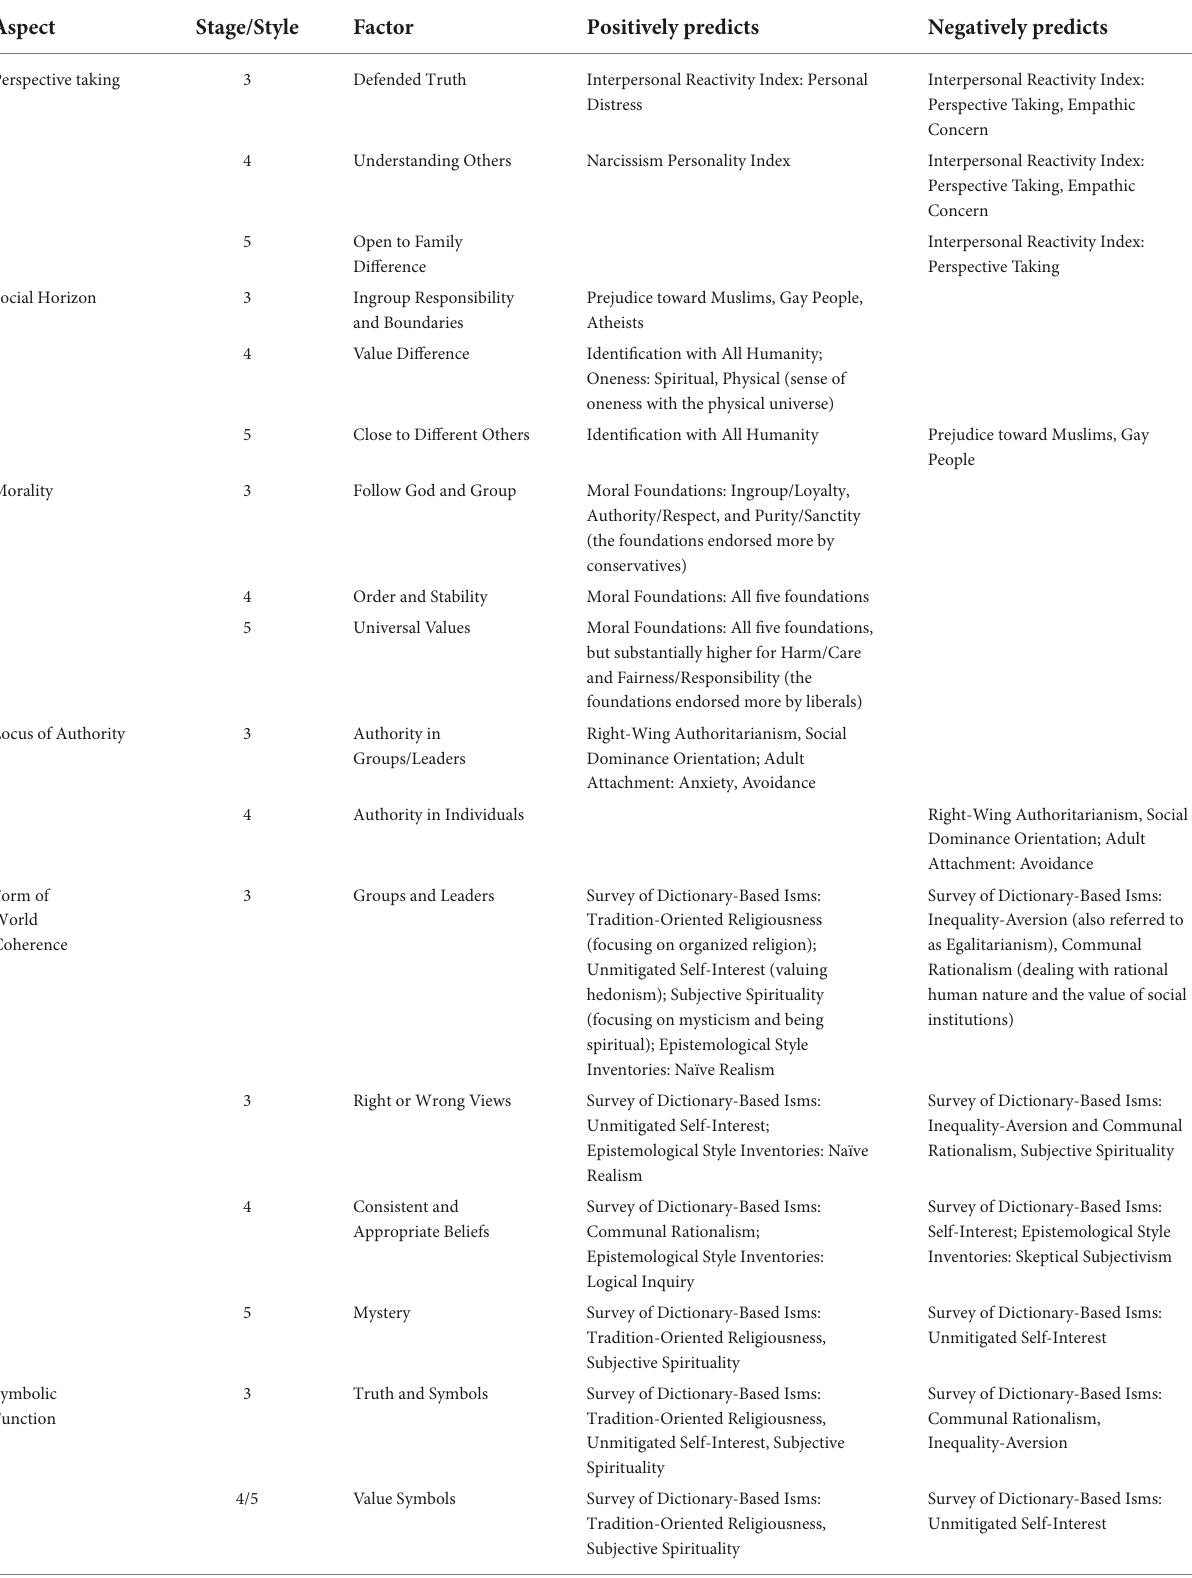
TABLE 4 Summary of key correlations between aspects of faith stage/styles and validation